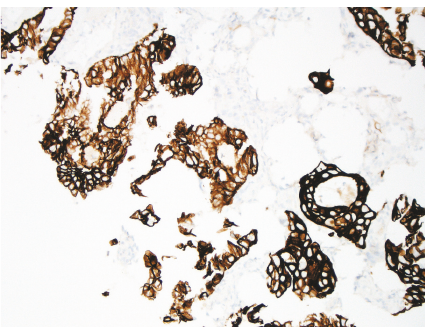
Figure 1: Large, ulcerated mass in the sigmoid colon seen during colonoscopy.